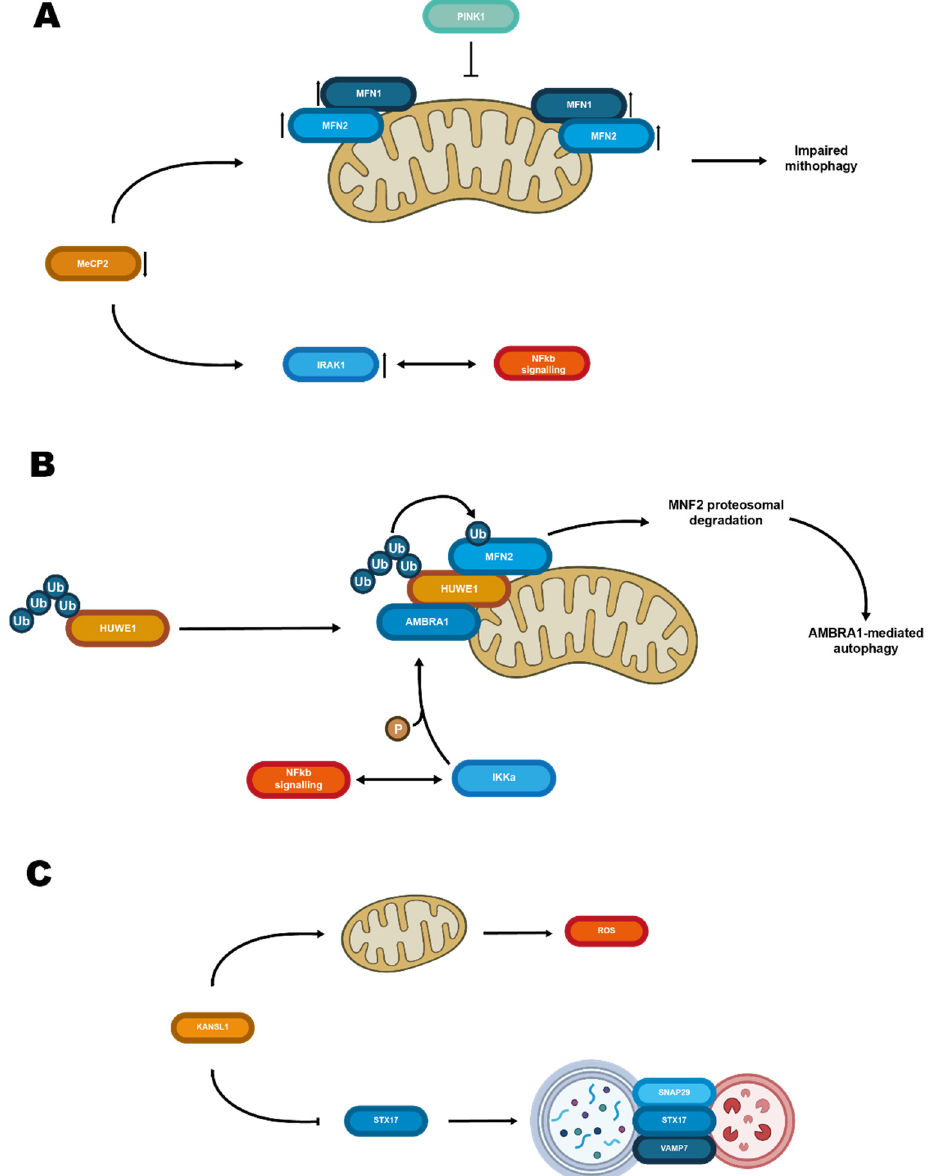
Figure 1. Schematic representation of chromatin remodeling proteins acting on cytosolic elements. ( A ) Mutations or downregulation of MeCP2 results in an increase of Mfn1 and Mfn2 on the mito- chondrial membrane impairing mitophagy. Moreover, it also upregulates IRAK1, possibly interfering with NFkb signaling, which results in further impaired neurologic phenotypes. ( B ) Mutations of Huwe1 result in impaired ubiquitination and proteasomal degradation of Mfn2 with a consequent decrease in autophagy. ( C ) Mutations of KANSL1 are associated with mitochondrial damage and ROS production. Suppression of STX17 expression limits autophagosome-lysosome fusion resulting in reduced autophagy.